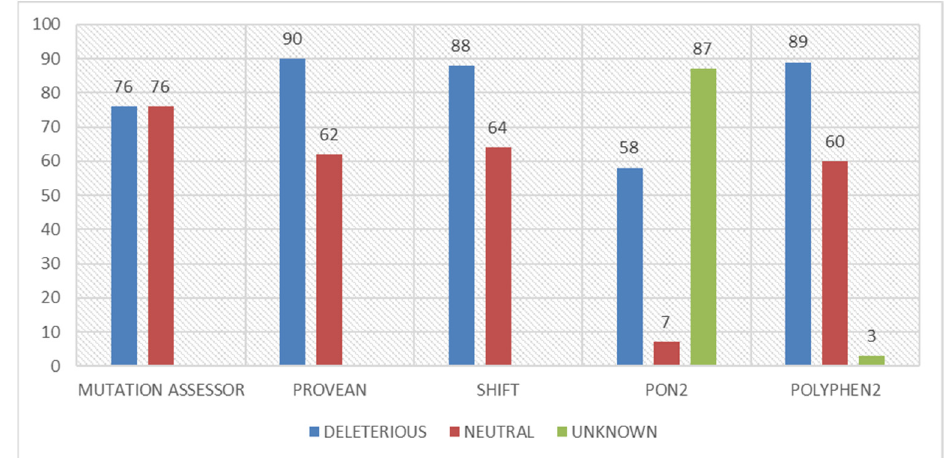
Figure 3. Deleterious, unknown, and neutral missense mutations’ distribution identified by sequence-based approaches for the entire sequence of the PARK7 protein.